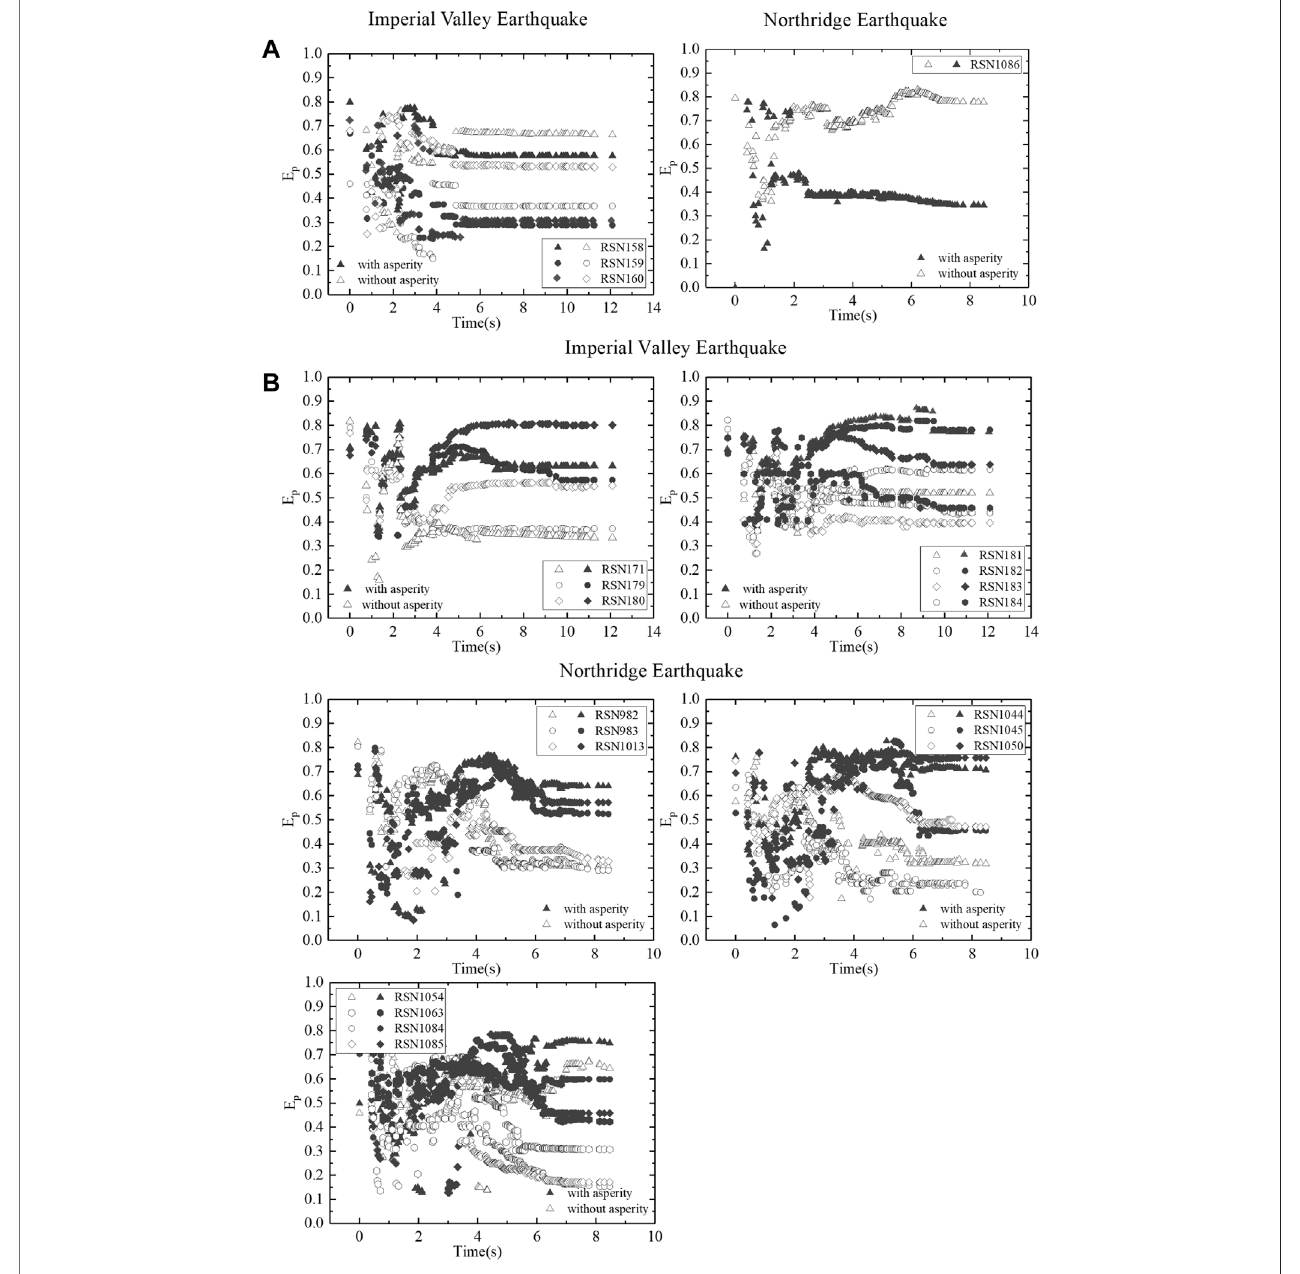
FIGURE 8 | E p values at (A) near-epicenter stations and (B) rupture-direction stations produced by homogenous and inhomogeneous slip distributions.